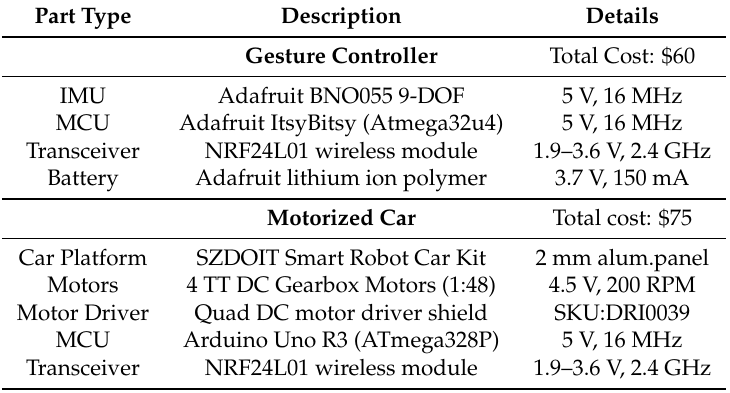
Table 1. GC-Rebot gesture controller and motorized car